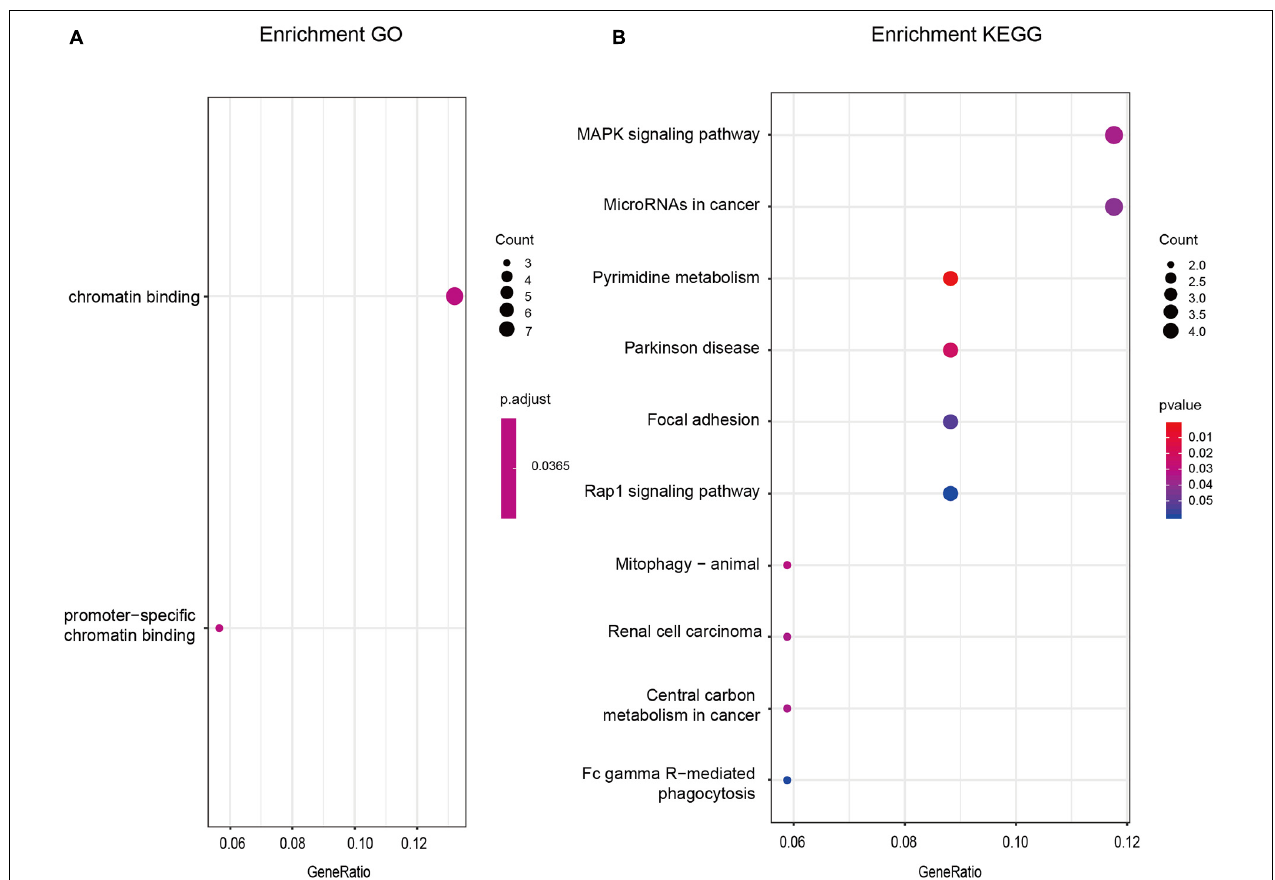
FIGURE 3 | GO and KEGG enrichment analysis of PmBs. (A) GO enrichment analysis. (B) KEGG enrichment analysis. GO, Gene Ontology; KEGG, Kyoto Encyclopedia of Genes and Genomes; GA, gastric adenocarcinoma.